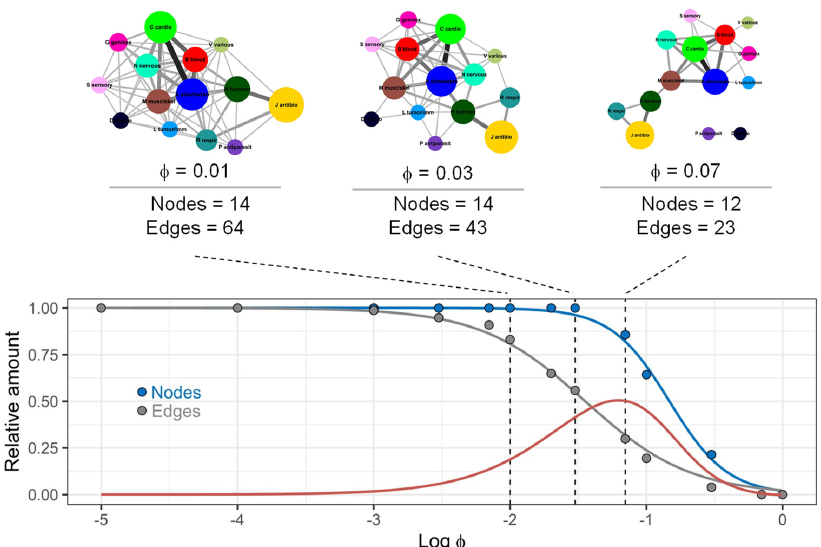
Figure A6. Relationship between φ -correlation and graph density. Drug prescription networks at the first ATC level were created by adopting different φ -correlation values (from 0.00001 to 1). The number of connected nodes (blue dots) and edges (grey dotes) in these networks was determined and analysed using logistic models (blue and grey lines, respectively). The red curve displays the difference between the blue and the grey curves; the x -coordinate of its maximum is denoted as φ max . Nodes are coloured according to the 14 groups found at the first level of the ATC classification system.